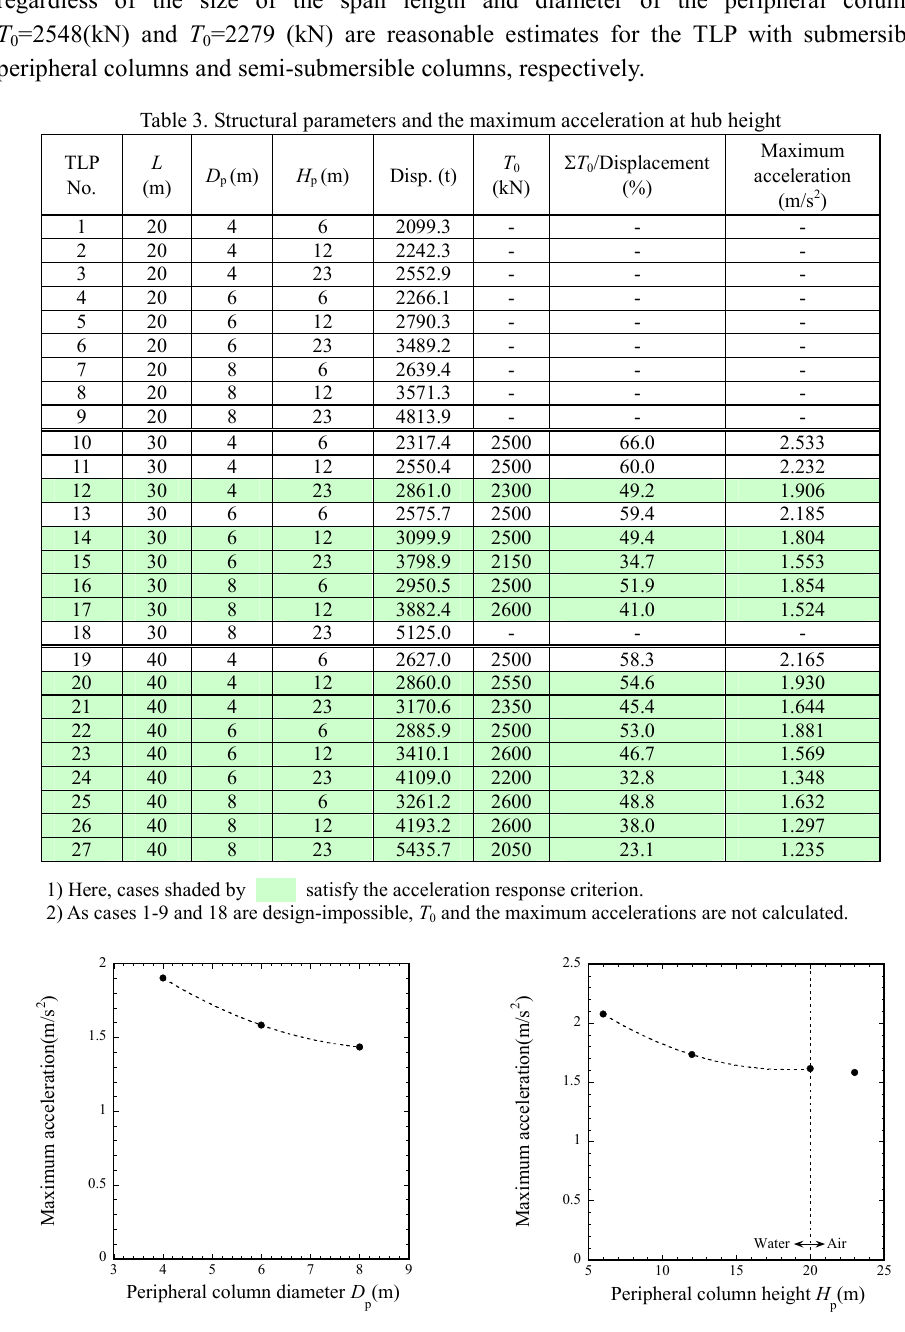
Fig. 11 Hub height maximum acceleration dependency on D p ( L : H p = 30 m: 23 m, T 0 = 2290 kN, under cut-out wind speed conditions, – 90°).